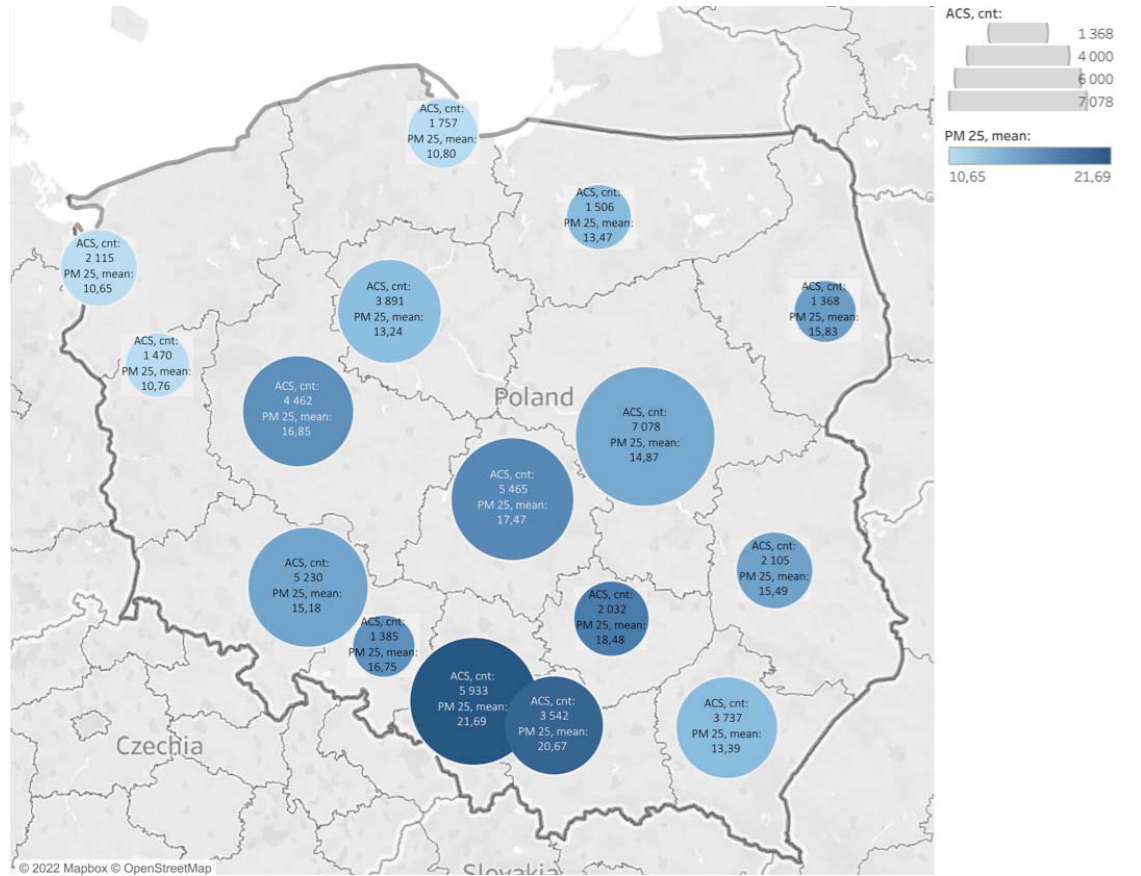
Figure 4. Distribution of acute coronary syndromes and mean PM2.5 levels in 2020. The circles indicate the accumulation of air pollution in a region. ACS—acute coronary syndrome.